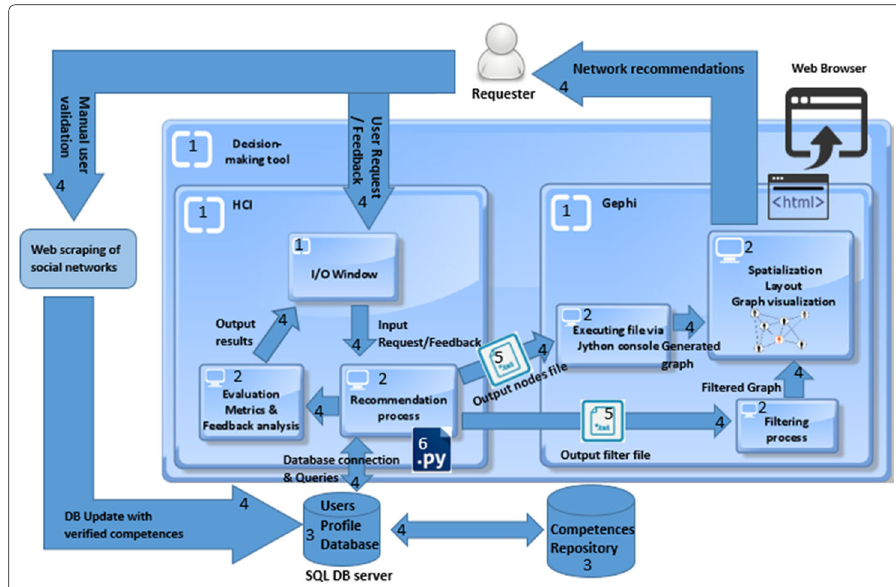
Fig. 3 System architecture & experimental platform with two main user interfaces: Gephi for network visualization, and a developed HCI for I/O data processing. 1: user interface 2: process 3: database 4: data